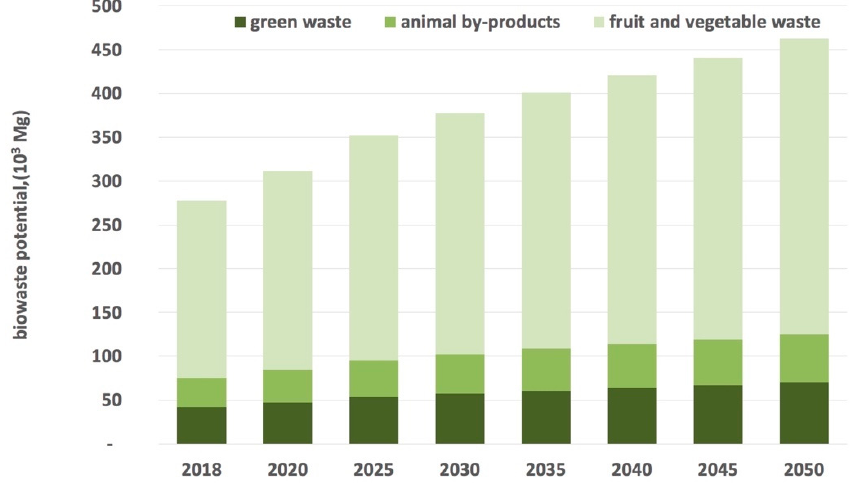
Figure 4. Biowaste potential in MSW in Warsaw.